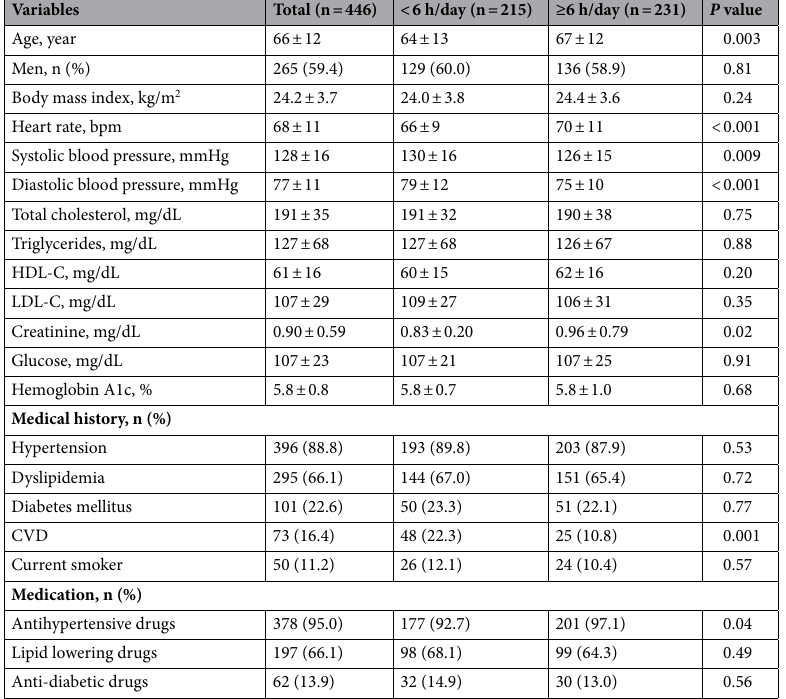
Table 1. Clinical characteristics of subjects with sitting time on a non-working day of <6 h/day and subjects with sitting time on a non-working day of ≥6 h/day. HDL-C indicates high-density lipoprotein cholesterol; LDL-C, low-density lipoprotein cholesterol; CVD, cardiovascular